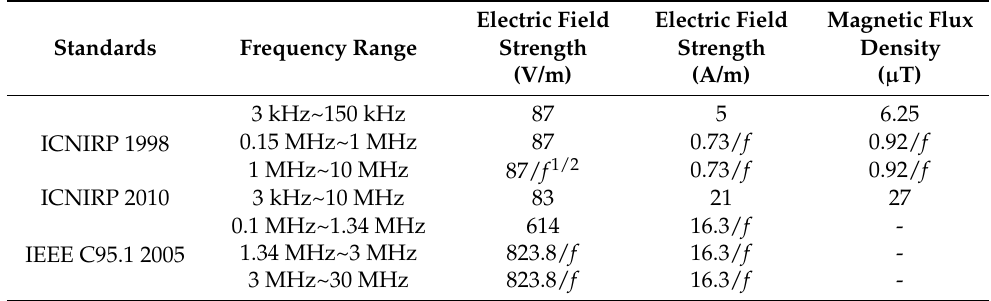
Electric Field Electric Strength